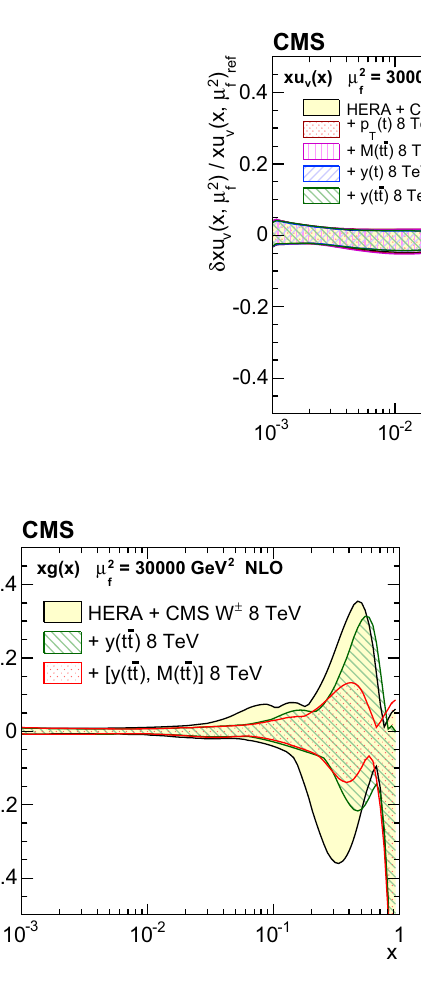
Fig. 18 Relative total uncertainties of the gluon distribution at μ 2 30 , 000GeV 2 , shown by shaded (or hatched ) bands , as obtained in the PDF fit using the DIS and W ± boson charge asymmetry data only, as well as single- and double-differential tt cross sections